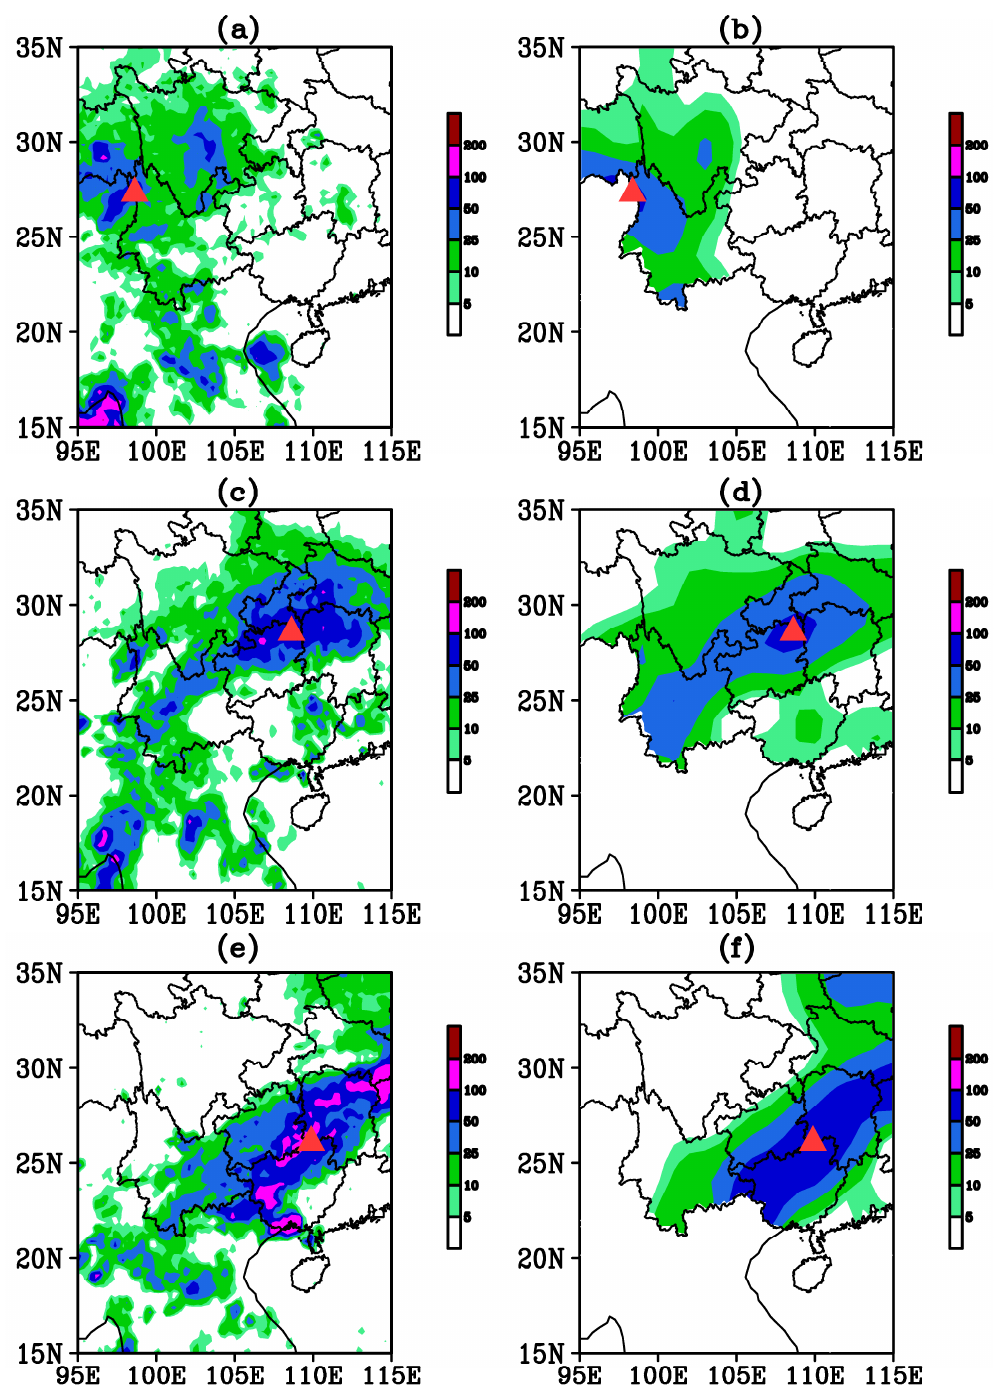
Figure 5. Daily precipitation (units: mm day − 1 ) on ( a , b ) 11 May 2002, ( c , d ) 12 May 2002 and ( e , f ) 13 May 2002. The left (right) panels are for the Tropical Rainfall Measuring Mission (China Meteorological Administration) datasets. The centers of maximum precipitation are indicated by triangle symbols.